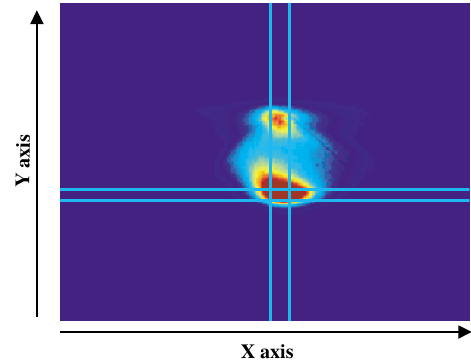
FIG. 4. (Color) Typical time-integrated Cherenkov image with superimposed slit locations of the streak camera in the hori- zontal and vertical